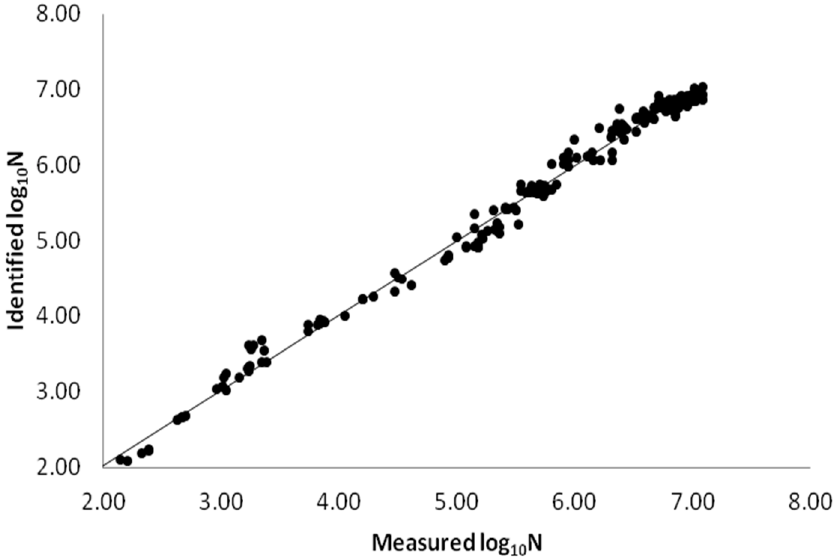
Figure 3. Plot of the correlation between observed and modelled values for log 10 N for survival in soils.